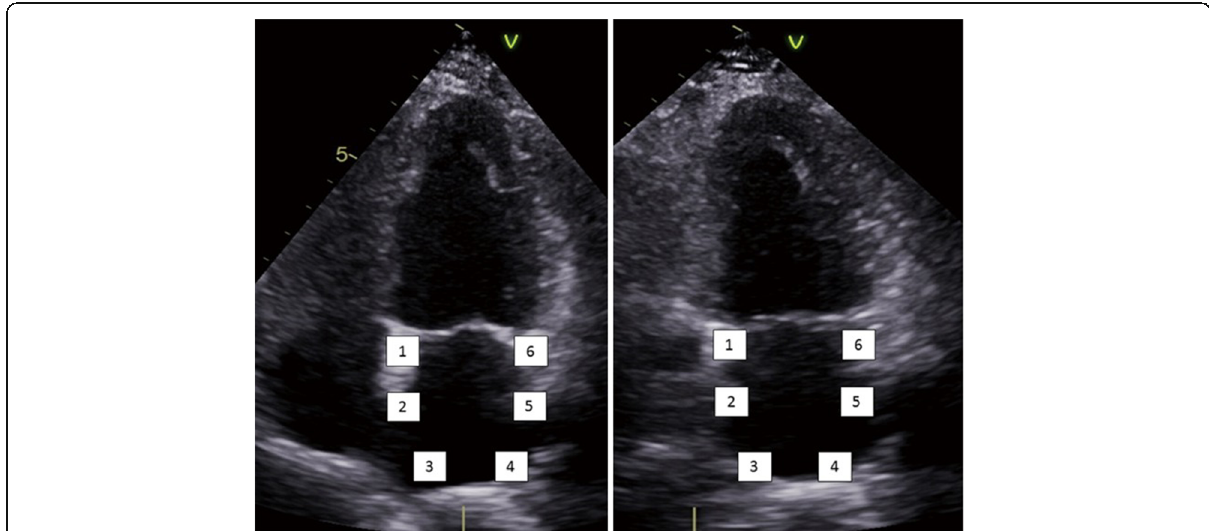
Fig. 1 Apical four-chamber and two-chamber views of the six left atrial